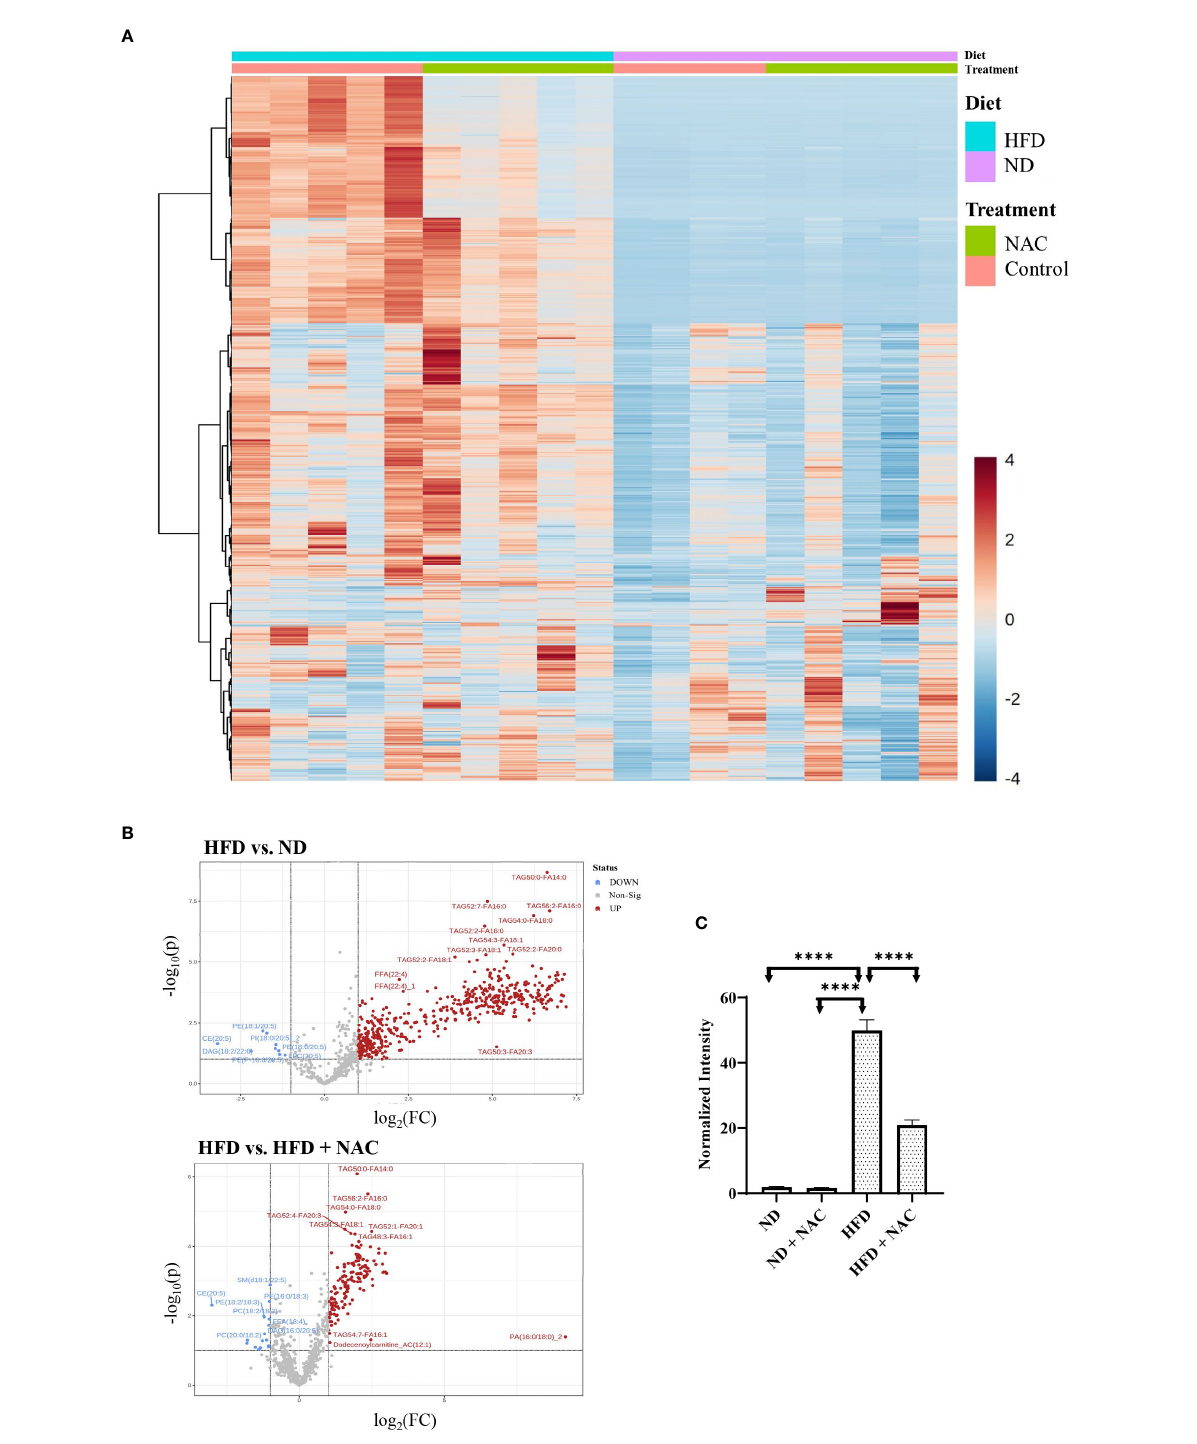
FIGURE 5 NAC treatment in HFD mice signi fi cantly altered the lipid pro fi le within the liver. (A) Heat map demonstrating the alterations in lipid composition with the respective tissue. (B) Volcano plots demonstrating the differences in upregulated lipid species in HFD vs. ND and HFD vs. HFD + NAC mice, ultimately revealing changes TAG composition within these tissues. (C) Histogram representing quantitative differences in TAG composition between the treatment groups. “ **** ”